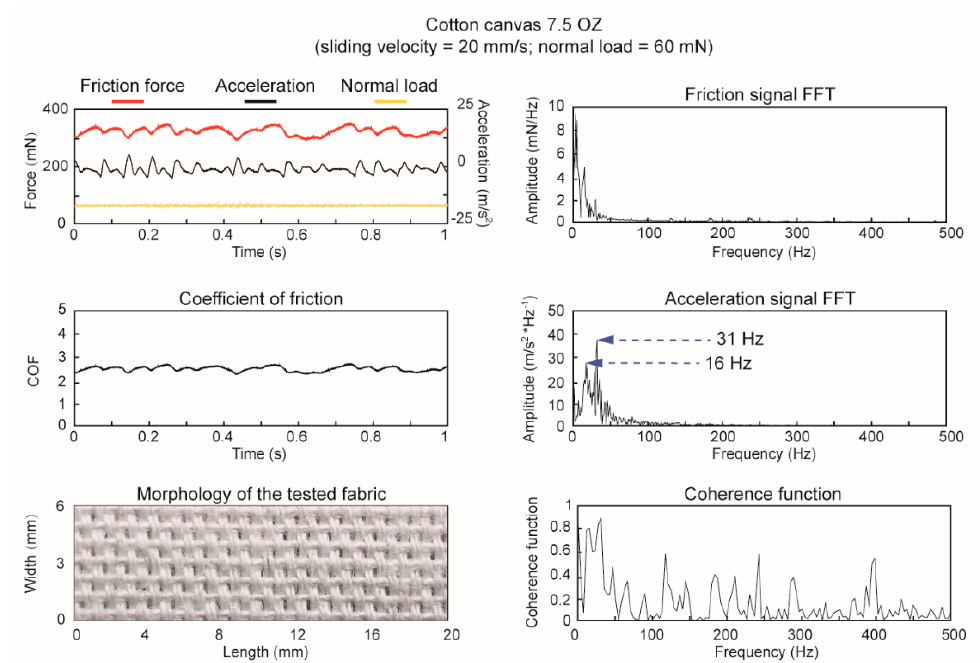
Figure 3. Friction force, acceleration, and normal load signals during a steel ball probe sliding on 7.5 (oz/yd 2 ) cotton canvas fabric at 20 mm/s scanning velocity under 60 mN preload are acquired. The spectra analysis of fiction force and acceleration by fast Fourier transform ( FFT ) were present and the coherence function analysis illustrated the relationship between the two signals.